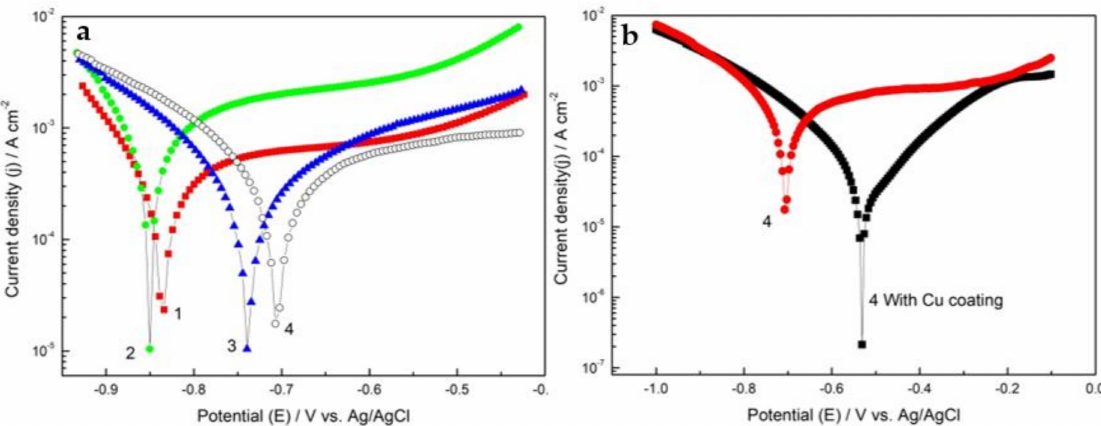
Figure 9. Potentiodynamic polarization curves of all test steels ( a ) and steel No.4 with Cu coating ( b ) in 3.5% NaCl